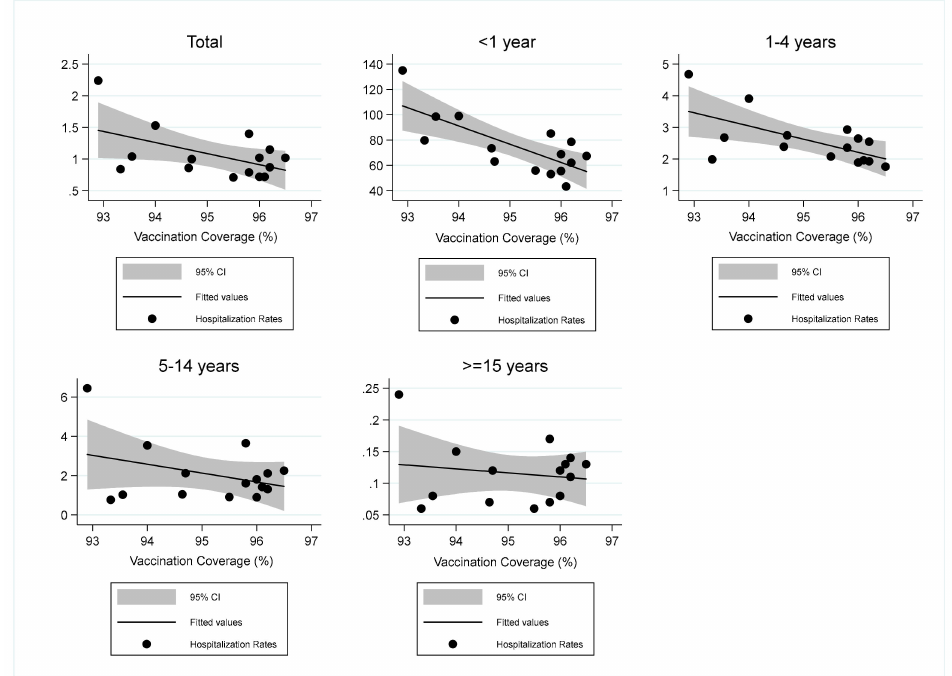
Figure 4. Scatter-plots and regression lines of pertussis hospitalization rates vs. vaccination coverage of 24 months old children in Italy (2002–2016 years). Linear regression analysis. Total: regression coe ffi cient (95% CI) = − 0.18 ( − 0.35– − 0.01); < 1 year: regression coe ffi cient (95% CI) = − 14.40 ( − 22.13– − 6.68); 1–4 years: regression coe ffi cient (95% CI) = − 0.42 ( − 0.73– − 0.10); 5–14 years: regression coe ffi cient